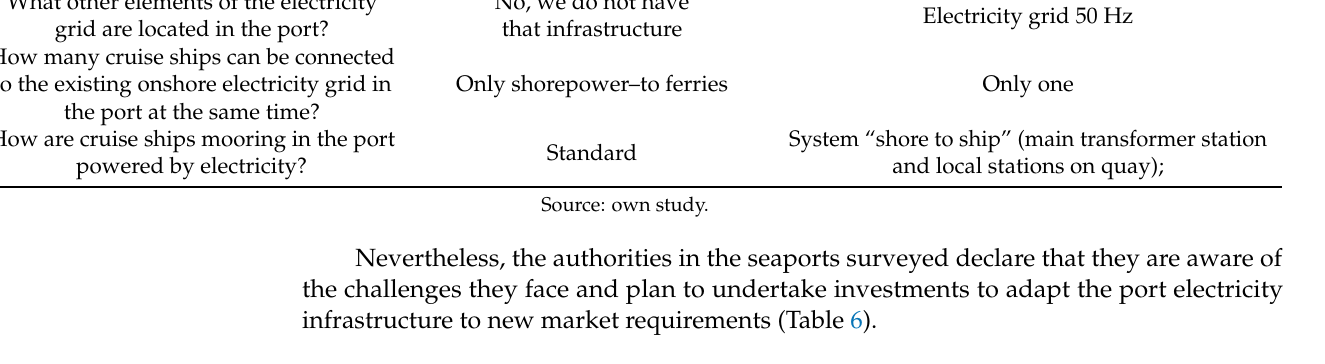
Table 6. Investments planned in seaports to provide Onshore Power Supply for cruise ships.